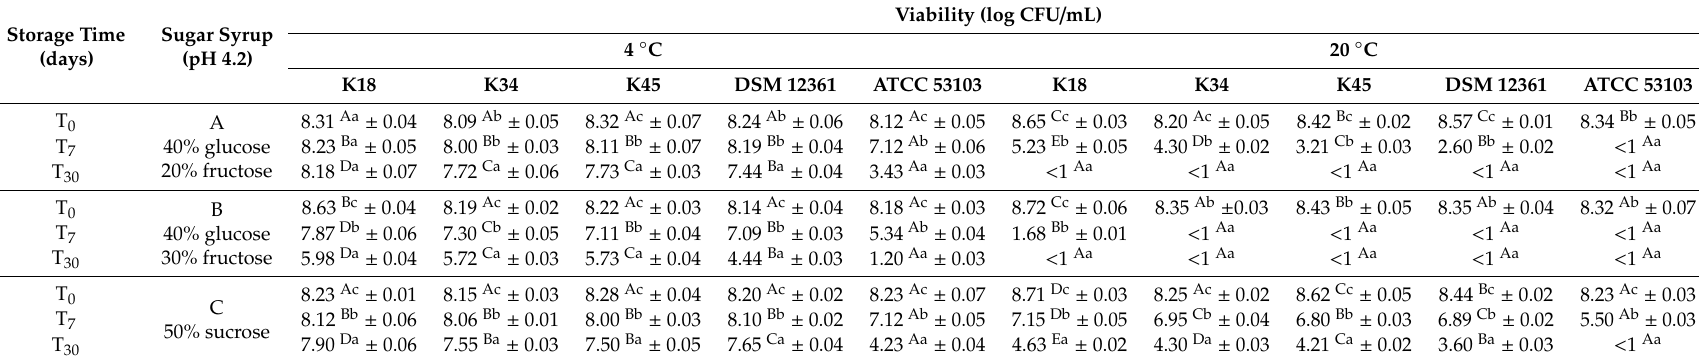
Table 5. Survival of A. kunkeei K18, K34, K45 and DSM 12361 and L. rhamnosus GG ATCC 53103 in di ff erent sugar syrups (A: 40% glucose + 20% fructose; B: